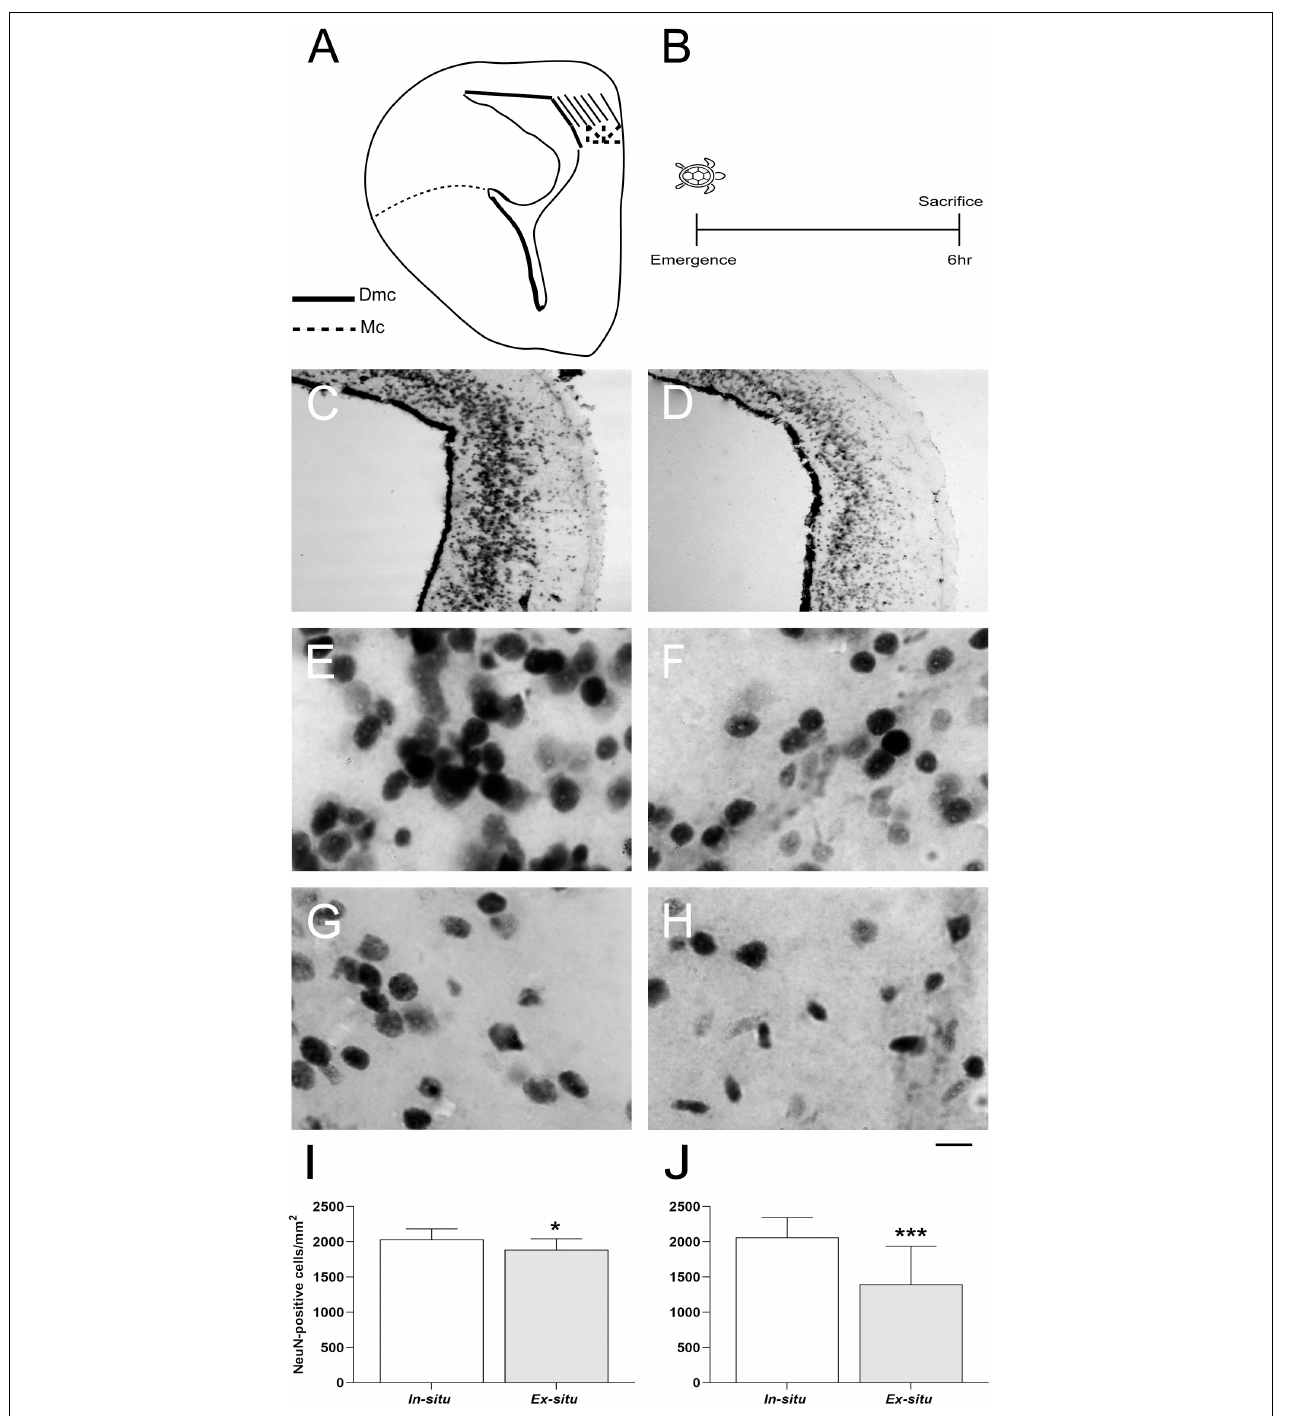
FIGURE 4 | Neuronal integration in brain areas homologous to the mammalian hippocampus in L. olivacea hatchlings. (A) Schematic drawing of turtle brain hemi-section showing the dorsomedial (Dmc, stripes) and medial (Mc, stippled) cortices. (B) Timeline for neuronal integration analysis. (C,D) Representative brain sections showing neuronal nuclear protein (NeuN) in the Dmc and Mc of one turtle from each condition ( in situ and ex situ , respectively). (E,F) Representative high magnification photographs showing NeuN + nuclei in the Dmc of one turtle from each condition ( in situ and ex situ , respectively). (G,H) Representative high magnification photographs showing NeuN + nuclei in the Mc of one turtle from each condition ( in situ or ex situ , respectively). (I,J) Graphs showing the density of NeuN + nuclei. In situ ( n = 5), ex situ ( n = 5). Mean ± SD, Type III Analysis of Variance * p ≤ 0.05, *** p ≤ 0.001, scale bar = 200 µ m for panels (C,D) and 50 µ m for panels (E–H)